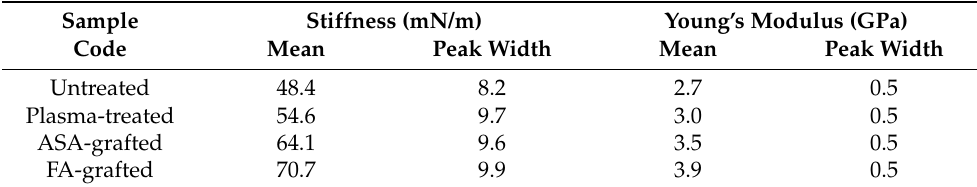
Figure 7. AM–FM AFM images (left: stiffness, right: Young’s modulus) and related histograms of PLA: ( a ) untreated, ( b ) plasma-treated, ( c ) ASA-grafted, and ( d ) FA-grafted. Table 2. Nano-mechanical properties of the PLA surfaces.